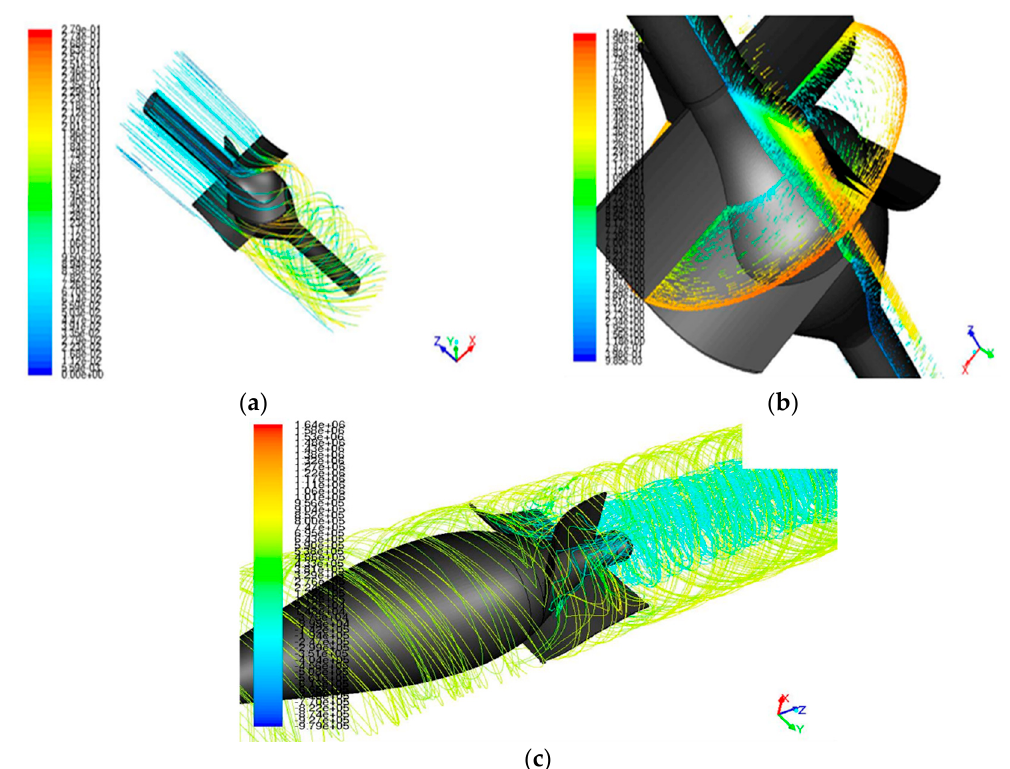
Figure 18. Different geometrical pump configurations: ( a , b ) short hemispheric hub with 5 blade and ( c ) long hub working like a diffuser.